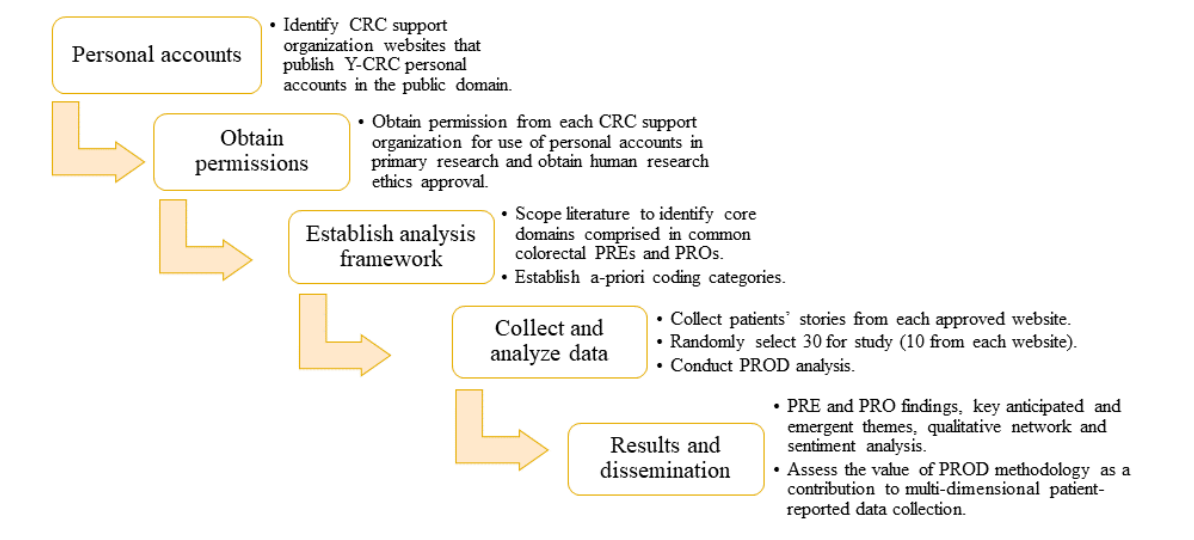
Figure 1. Flowchart of the study design. CRC: colorectal cancer; Y-CRC: young-onset colorectal cancer; PRE: patient-reported experience; PRO: patient-reported outcome; PROD: personal recollections organized as